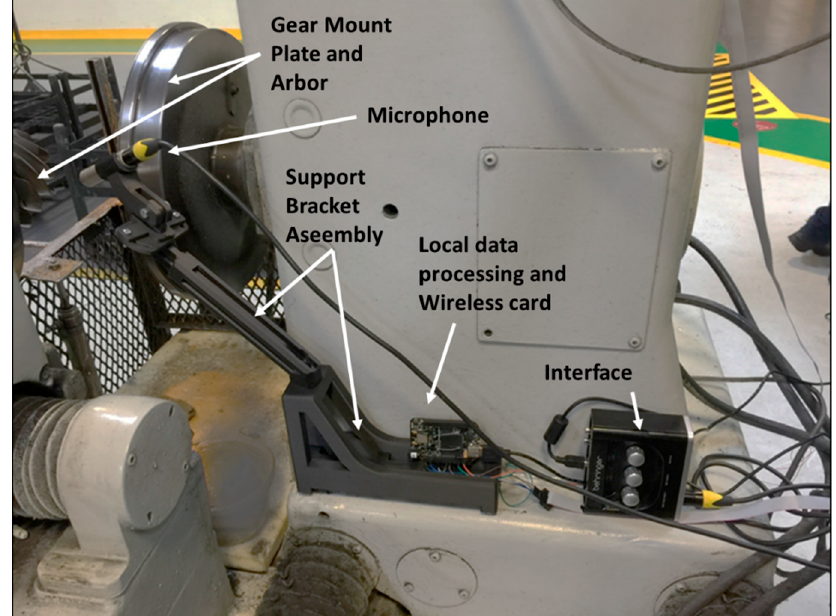
Figure 5. Equipment for the audio signal monitoring system: Support bracket assembly unidirectional microphone, interface, and BeagleBone wireless card.